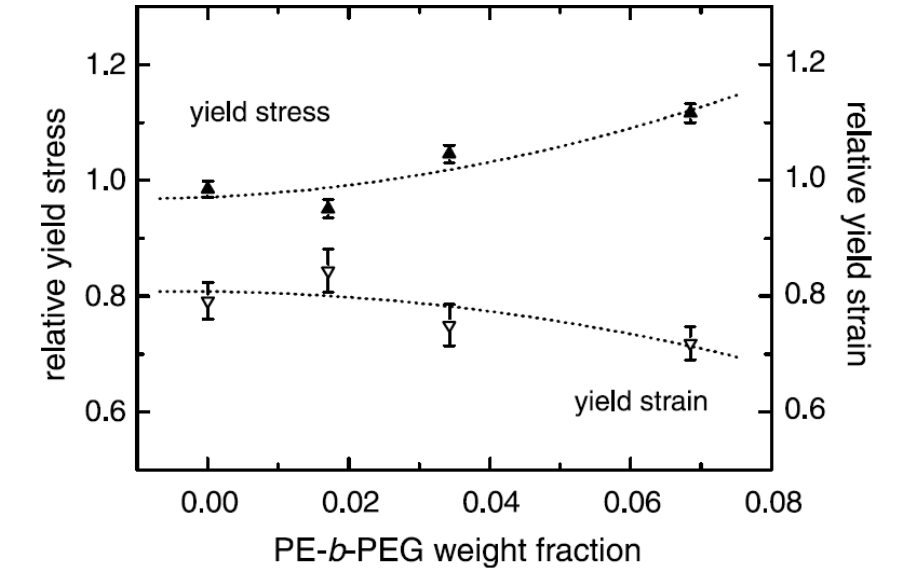
Figure 36. Yield stress and yield strain of the polyethylene nanocomposites as a function of the amount of the block copolymer based compatibilizer. Reproduced from reference [136] with permission from